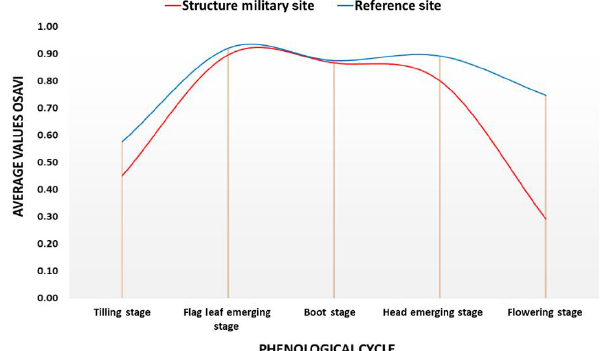
Table 5. Same as Table 3 but for the boot stage.